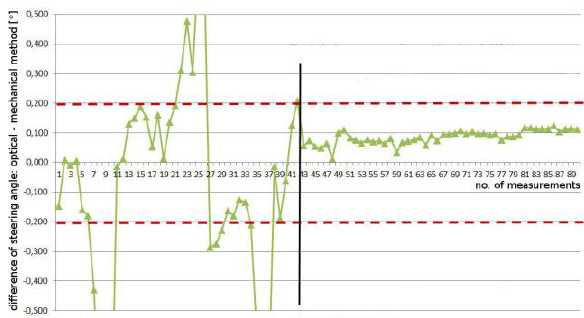
Figure 10. Differences of optical and mechanical determined steering angles. Up to measurement 42 (vertical line) the effect of concussions caused by the production environment is clearly visible. After measurement 42, the camera was stabilized. 5.2.1 2D Shape-based Matching: The results of the 2D approach are visualized in Figure 11. 291 measurements including 27 different vehicles are plotted in the histogram of the obtained differences to the mechanical steering wheel balance. The red line indicates the accumulated differences. Only 21,4% of the measurements lie beneath the threshold of 0.2°. A wide variation of differences is clearly visible. The detection rate is 100%, i.e. for each image the distinctive elements could be automatically recognized and the steering angle could be calculated. The standard deviation for the plotted differences is ±0.48°.